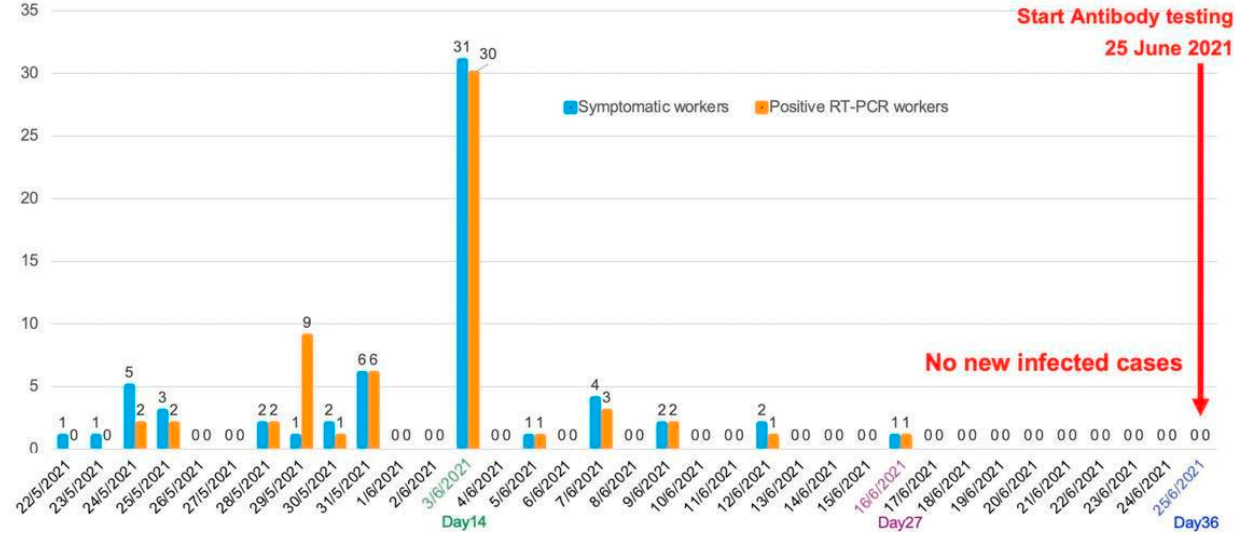
Figure 2. Date of diagnosis and number of RT-PCR confirmed COVID-19 workers among the migrant workers with respiratory symptoms during the time between the triage and antibody testing of the Bubble and Seal program (21 May 2021–25 June 2021).